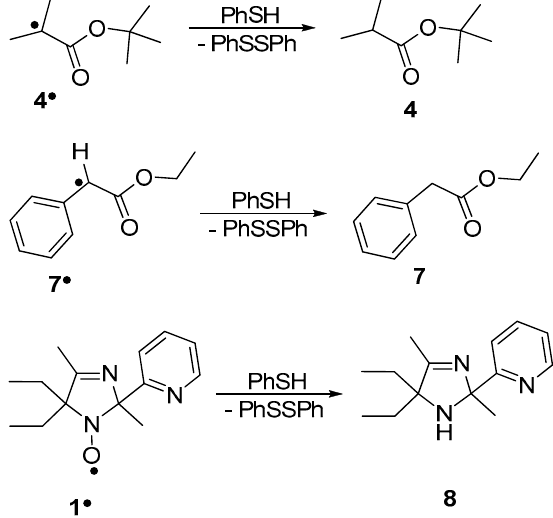
Scheme 6. Decomposition of alkoxyamines 2 RS/SR and 3 in the presence of PhSH.